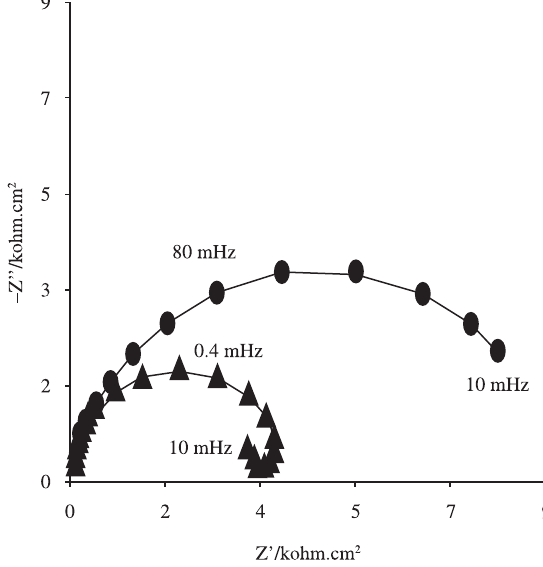
Figure 8. Nyquist plots of Ti6Al4V obtained after 1 day ( ● ) and 7 days ( ▲ ) immersion in citrate solution pH 5.0 containing 0.1 M NaF. Fitted curves in solid